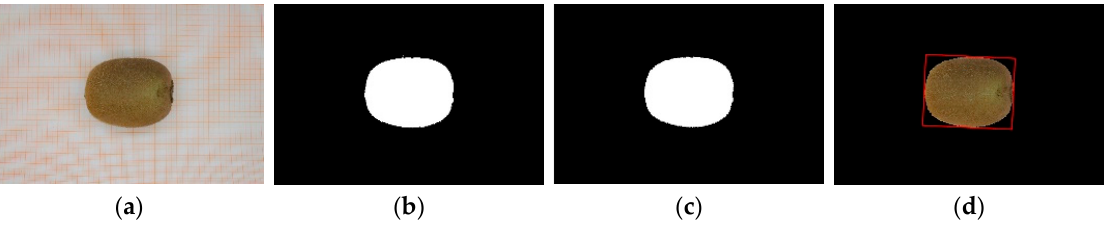
Figure 2. Steps of measuring kiwifruit sizes by image processing methods. ( a ) Original red-green-blue (RGB) color image in a coordinate paper; ( b ) black and white image after using the threshold technique; ( c ) fruit projected area image by eliminating noises using an area threshold method; and ( d ) computed minimal bounding rectangle (red box) of the fruit area to calculate fruit length and MaDES.